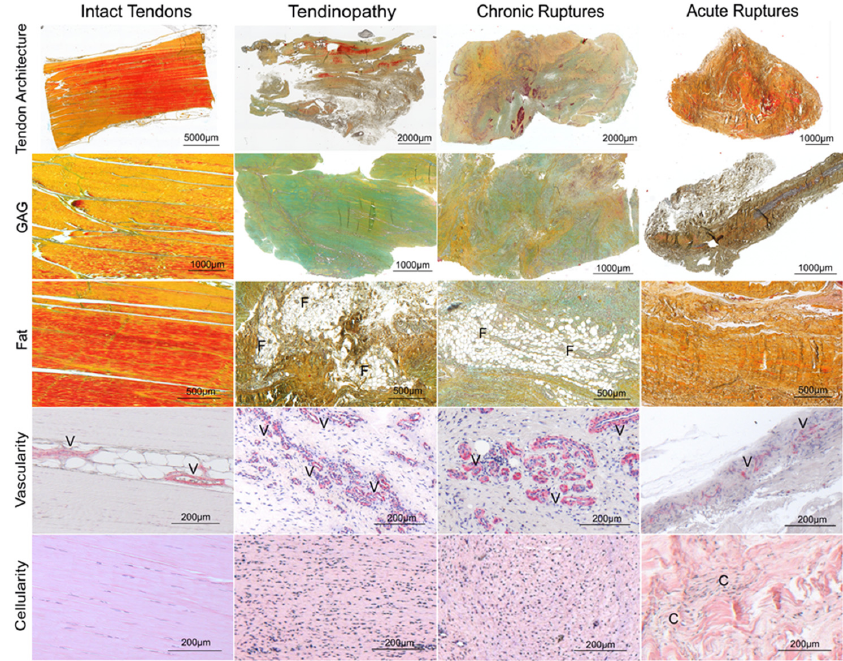
Figure 1. Exemplary histologies of intact tendons, tendinopathic tendons, chronic ruptures and acute ruptures using Movat Pentachrome (MP) staining (tendon architecture, glycosaminoglycan (GAG) and fat tissue (lipid vacuoles)), α smooth muscle actin ( α SMA) staining (vascularity) and Hematoxylin and Eosin (HE) staining (cellularity). F: fat tissue, V: vessels, C: cell clusters. The Movat Pentachrome staining used stains collagen in yellow to brown, mature collagen in red [31], GAG ground substance in turquois, cell nuclei in blue to black and cytoplasm stains reddish.